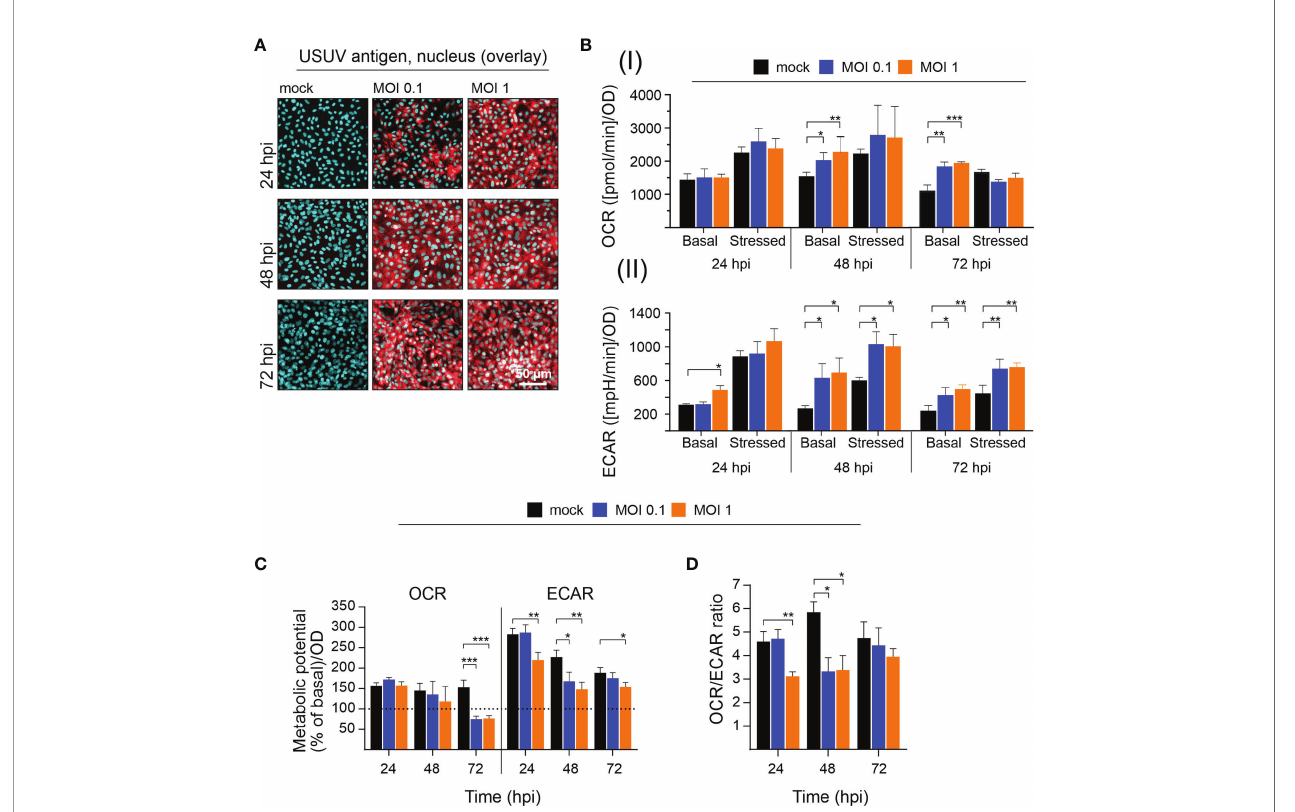
FIGURE 1 | Extracellular fl ux measurement indicates an increase in glycolytic activity in Vero cells after infection with USUV. A low (of 0.1) and a high (of 1) MOI were applied to address the in fl uence of USUV load on (A) infectivity rate and (B – D) metabolic activity in Vero cells. (A) For indicated time points the number of infected Vero cells was qualitatively assessed by fl uorescence microscopy after immuno fl uorescence analysis with pan- fl avivirus antibody (shown in red as a representative for n = 3 together with nuclear counterstain DAPI in blue). (B) Quanti fi cation (mean ± SD, n = 3) of (I) OCR and (II) ECAR under basal and stressed (after co-injection of inhibitors and thus under induced energy demand) conditions. (C) The metabolic potential was determined through the percent increase in stressed OCR and ECAR over basal OCR and ECAR. (B, C) Calculations were performed by the energy phenotype test report generator software. (D) OCR/ECAR ratio was calculated based on basal OCR and ECAR as determined at measurement point 3 of extracellular fl ux measurements. (B – D) Data are shown as mean ± SD (n = 3). Statistical signi fi cance is indicated as *p < 0.05, **p < 0.01, and ***p < 0.001, performed by ANOVA and Dunnett ’ s post-hoc multiple comparisons